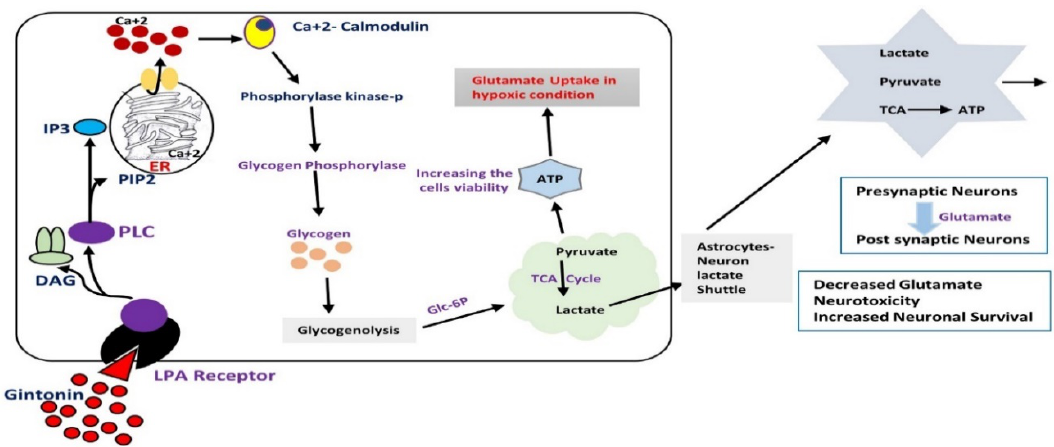
Figure 7. Diagram highlighting the effects of gintonin on astrocytic glycogenolysis in primary cortical astrocytes. Gintonin-mediated astrocytic glycogenolysis might be coupled with intracellular and intercellular mechanisms. Intracellularly, gintonin may reduce ATP, upregulate the glutamate level, and increase cell viability under hypoxia- and reoxygenation-induced conditions. The intercellular activities of gintonin-mediated astrocytic glycogenolysis are also tied to the astrocyte-neuron lactate shuttle, permitting neurons to use lactate under hypoxia or reoxygenation conditions and regulate glutamate toxicity by handling the unnecessary extracellular glutamate under hypoxic conditions. DAG: diacylglycerol, IP3: Inositol trisphosphate, LPA receptor: Lysophosphatidic acid receptors, PLC: Phospholipase C. PIP2: Phosphatidylinositol Biphosphate.